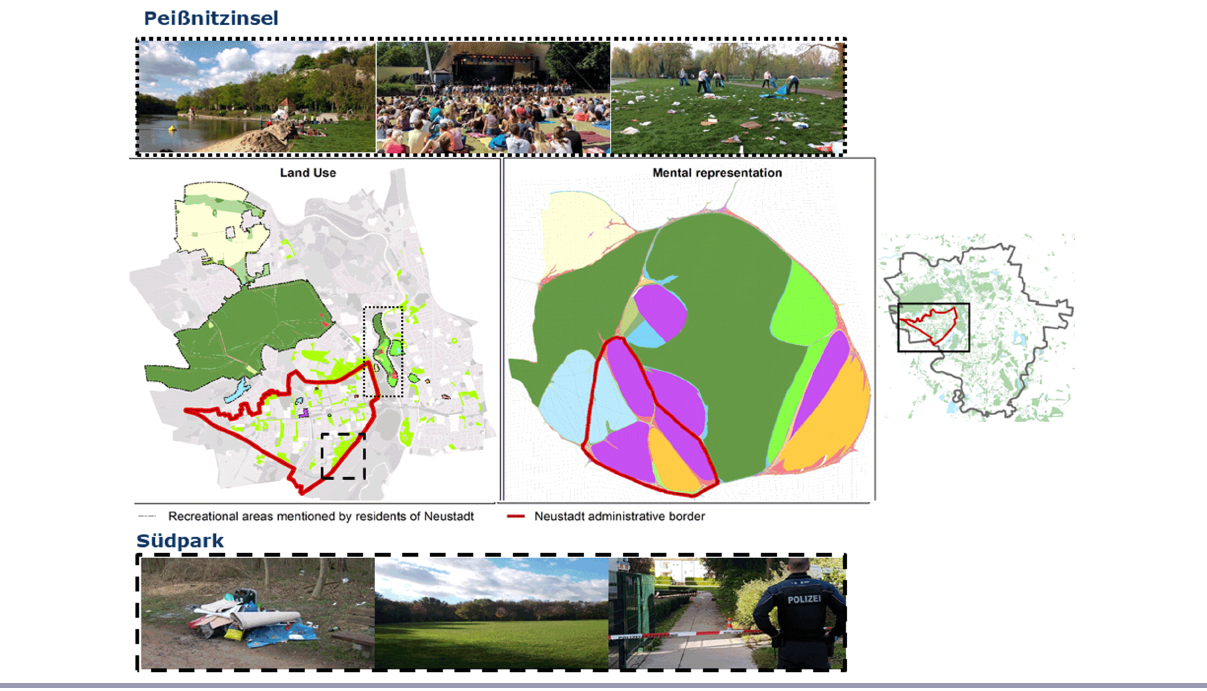
Fig. 6 . The central section of the figure shows, left map, the real situation and distribution of the green-blue infrastructure (GBI) network in both places, Saale floodplain and Halle-Newtown and, right map, the mental representation of the most important green spaces of the Halle Newtown residents, as discussed in the text and resized by the number of entries. Halle Newtown and its GBI appear much smaller in this synthetic mental map when compared to the Halle Saale-floodplains GBI. The pictures in the lower section explain why. The boxes refer to the photo bars above and below the two maps and the needled box refers to the Klausberge (in German: Klaus Mountains) some of the respondents referred to and the dotted box to the central Peißnitz island we talk about in the preference and MM analysis (Layout: Manuel